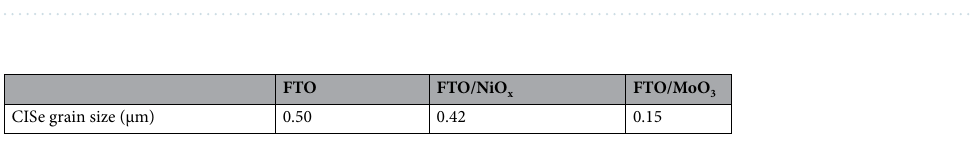
Table 1. The grain size of CISe films deposited on different